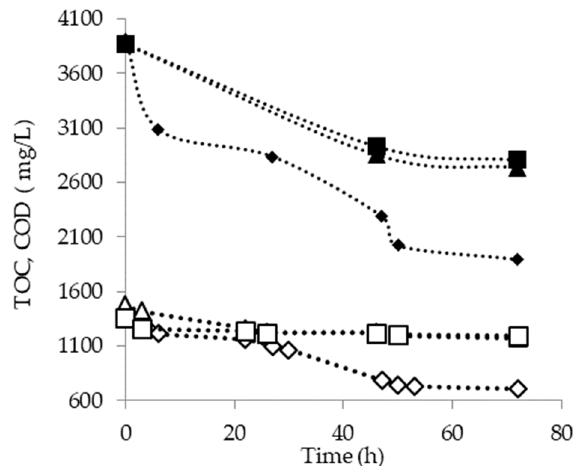
Figure 6. Effect of temperature on aerobic biological treatment of pyrolysis wastewater. COD (full symbols) and TOC (empty symbols) at 15 °C (triangle), 25 °C (square) and 30 °C (rhomboid). As expected, the TOC and COD removal rate increased when temperature increased. TOC removal was 12.62%, 20.90% and 49.47% for tests performed at 15 °C, 25 °C and 30 °C, respectively,